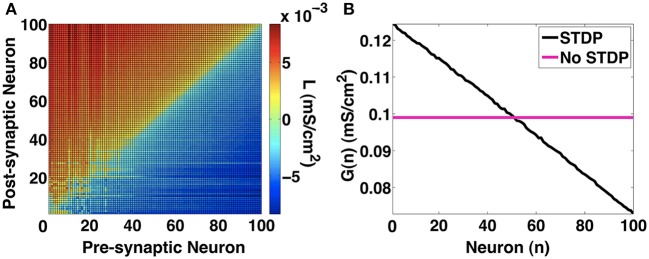
Network metrics. (A) Link imbalance of the 100-MCI network when H = 10. The synaptic strength differences between pairs of neurons are color coded. In general synapses originating from slower neurons (lower numbers on x-axis) have a positive network imbalance value. (B) The neuron strength metric measures the total outgoing synaptic strength for each neuron. With STDP, neuron strength linearly decreases in the direction of slowest firing neuron to the fastest neuron, indicating greater synaptic influences of slower neurons.